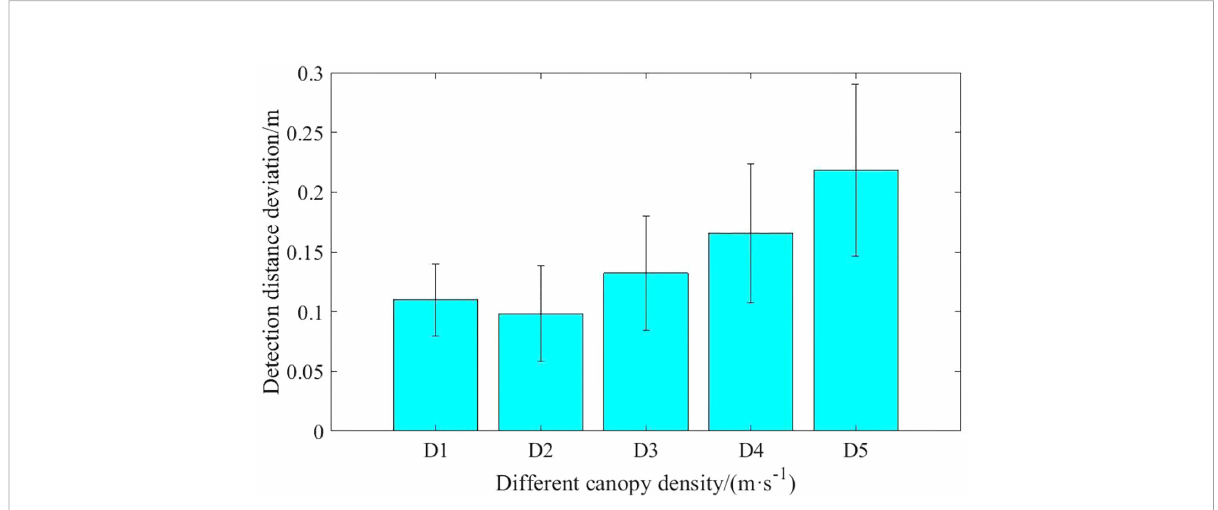
FIGURE 21 Comparison of wheat canopy and non-canopy with different density. The detection speed has no obvious in fl uence on the detection